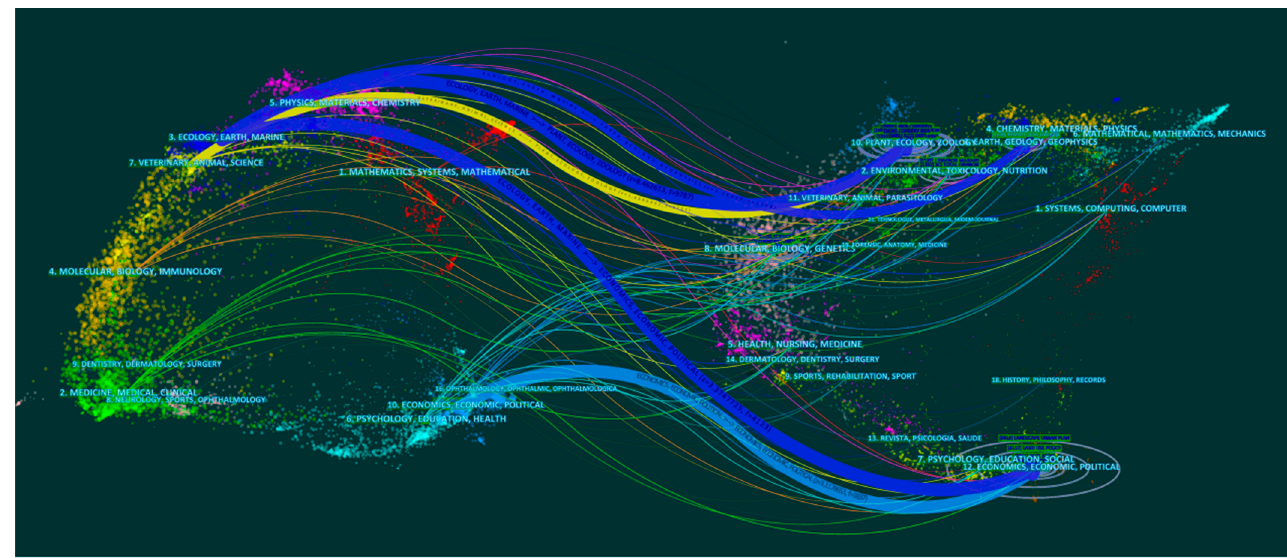
Figure 8. Dual-map overlay showing the correlation between RLES disciplines from 2006 to 2021.